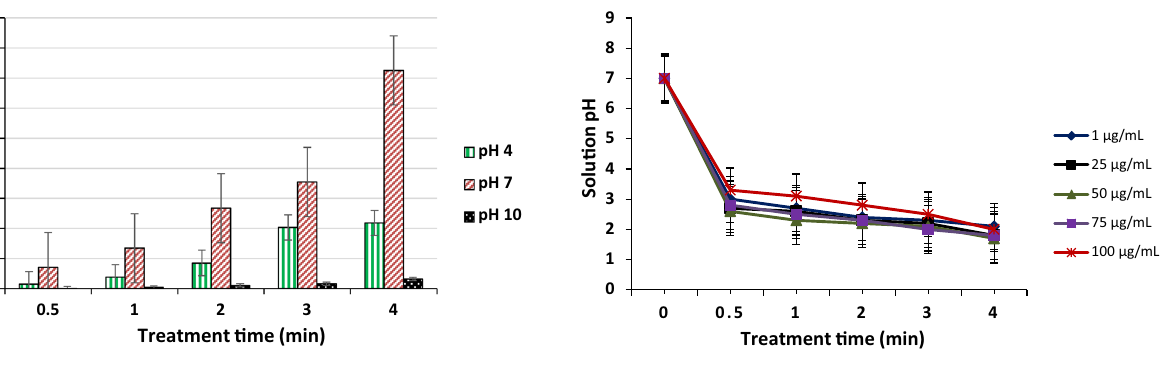
Fig. 6 Effect of initial pH on the removal efficiency (%) of caffeine from water samples in DBD plasma reactor. Initial caffeine concen- tration: 100 µg/mL; input power: 60 W; solution volume: 20 mL